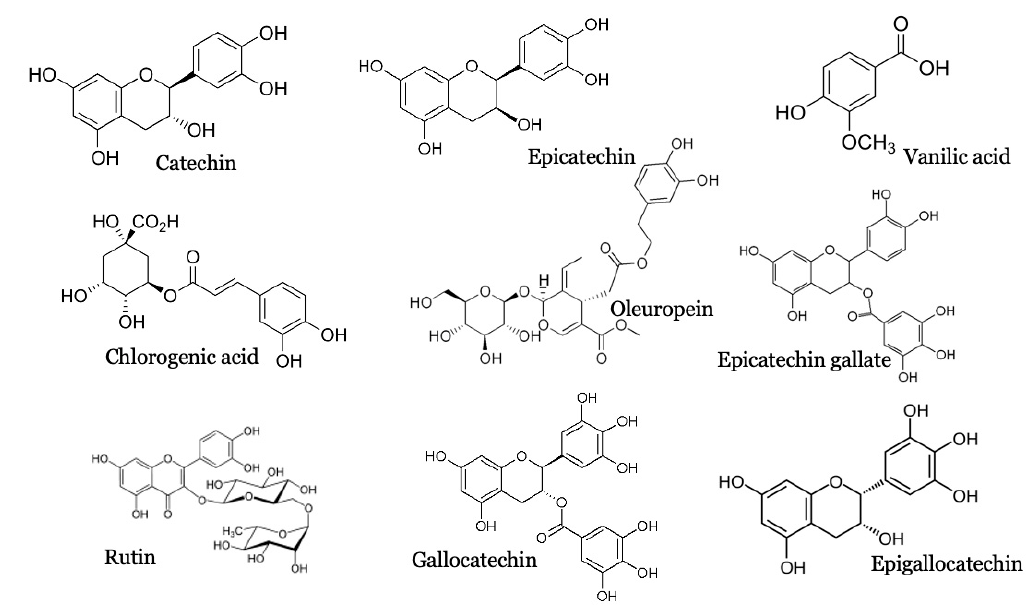
Figure 2. 2D structure of PCS-identified molecules.